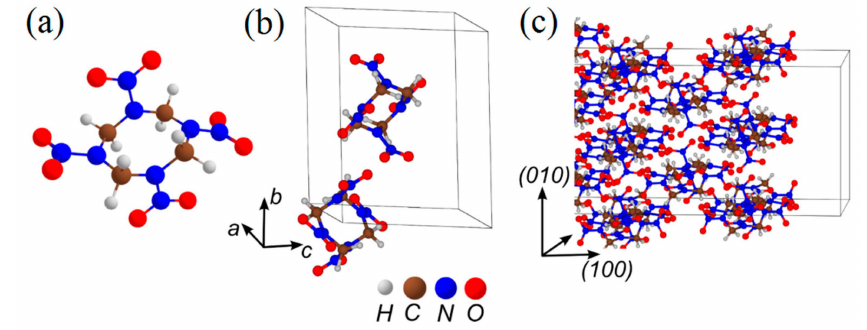
Figure 4. The structure of ( a ) an HMX molecule; ( b ) an HMX ideal crystal; and ( c ) a model supercell fragment of the (100) HMX